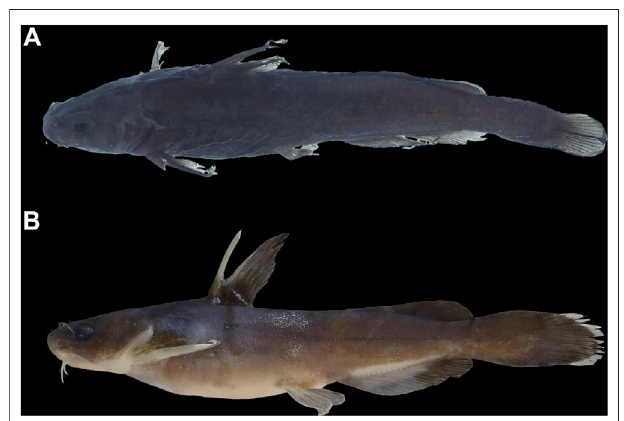
FIGURE 7 | Lateral view of T. analis for: (A) AMNH 6421, hopotype; 101 mm SL; Hekou, Yanshan, Jiangxi Province, and (B) IHB201707014311, 124.2 mm SL, Yudu county, Jiangxi Province, in